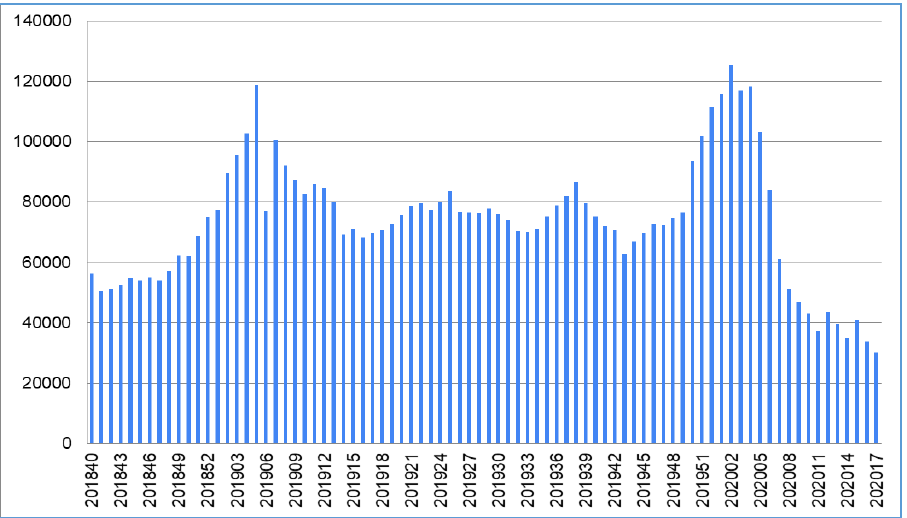
Figure 2. Influenza-like illness cases. Note: National Statistics of influenza-like illness (ILI), data extracted and analyzed from Taiwan CDC systems [6]. x -axis: year-week interval & y -axis: number of cases.